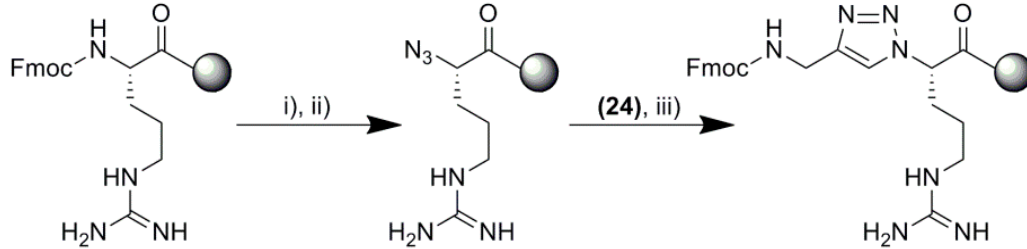
Figure 3. The general scheme of triazole rings synthesis on solid support. Reagents and conditions: (i) 20% piperidine in DMF; (ii) trifluoromethanesulfonyl azide in DCM, MeOH and K 2 CO 3 , CuSO 4 in H 2 O (2:1:1 v / v / v ), and Fmoc-propargylamine 24 ; (iii) THF and CuSO 4 , sodium ascorbate in H 2 O (2:1 v / v ).